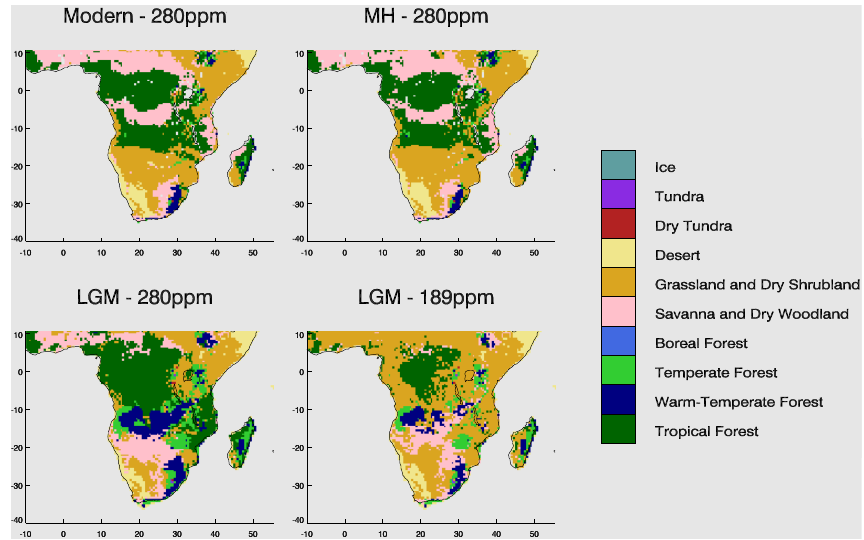
Fig. 3 . Simulated biome distributions for PI, MH (model-average climate), LGM (model-average climate and pre-industrial CO 2 , 280ppm) and LGM (model-average climate and realistic CO 2 ,